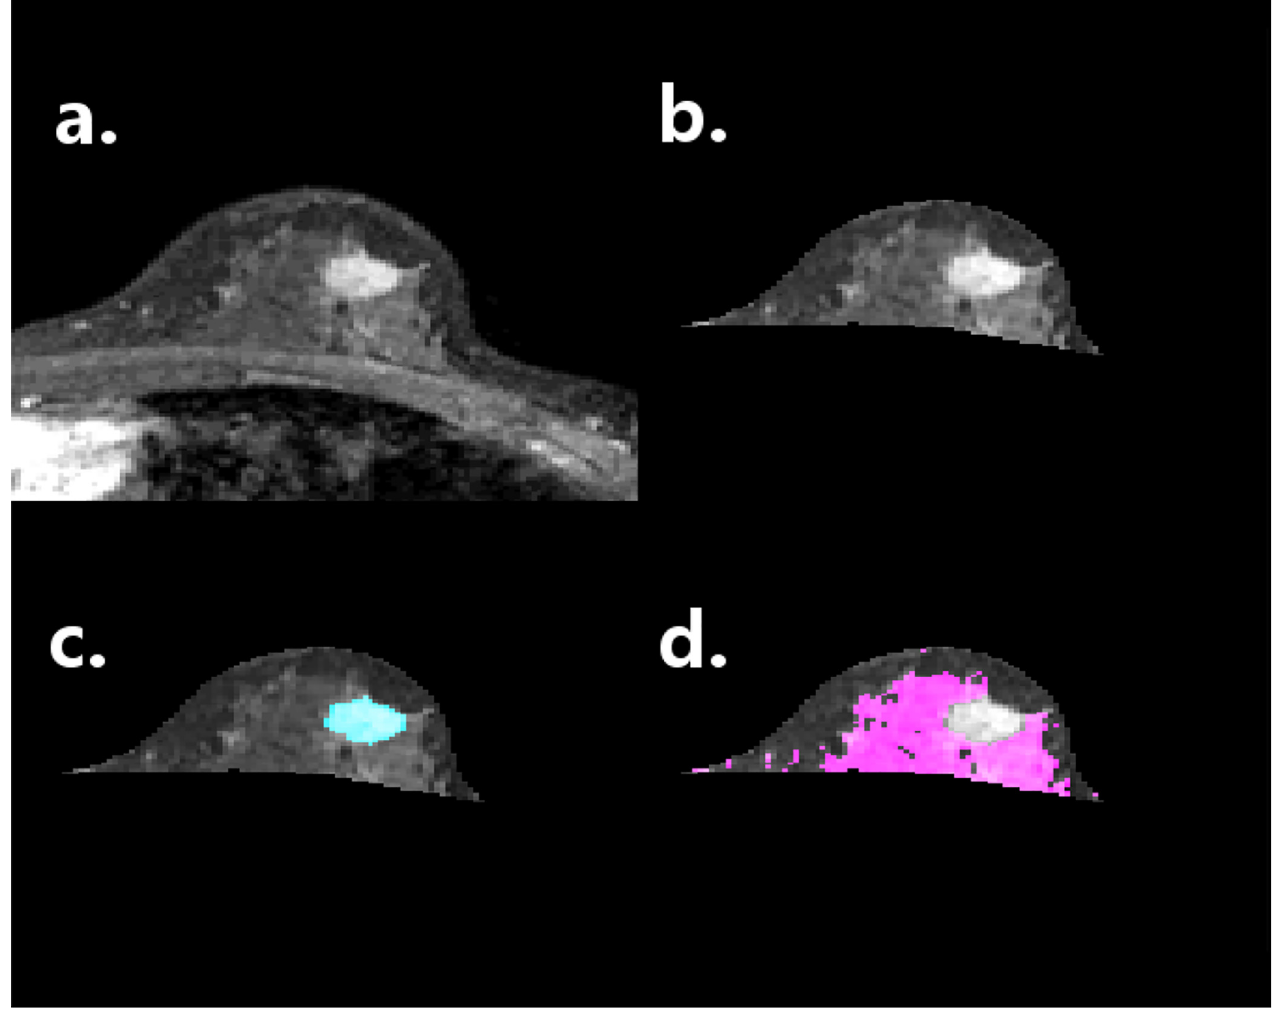
Fig 1. Example of tissue segmentation performed of all cancer patients ’ affected breast images. At top left (a), a dynamic contrast-enhanced MRI exam at t3 is seen in the axial plane, illustrating one slice of the view used for contouring the breast and tumor. At top right (b), the result of breast segmentation is shown. At bottom left (c), the segmented tumor is highlighted in blue. Finally at bottom right (d), the parenchyma segmented at t1 is highlighted in pink. Breast subcompartment segmentation was performed in